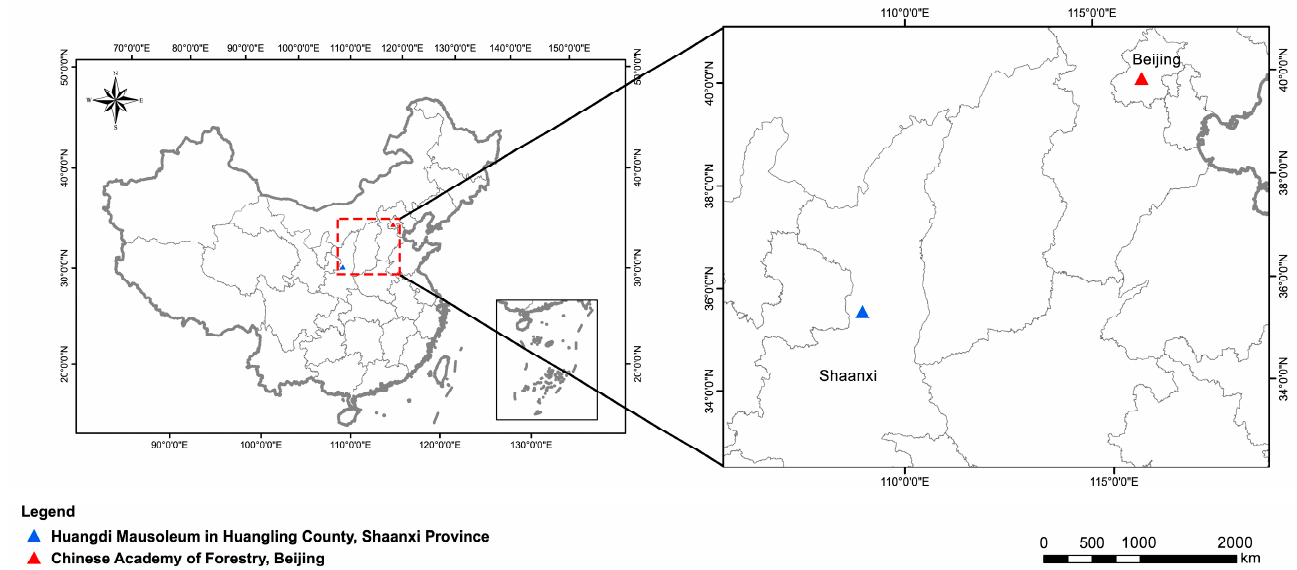
Figure 10. The location of the sampling point distribution area. The different ages (5-, 2000-, and 3000-year-old) P. orientalis for seed sowing, cutting, and grafting were collected from Huangling County, Shaanxi Province, China (35°58 ′ 52.84 ″ N, 119°27 ′ 12.27 ″ E). Field experiments were located